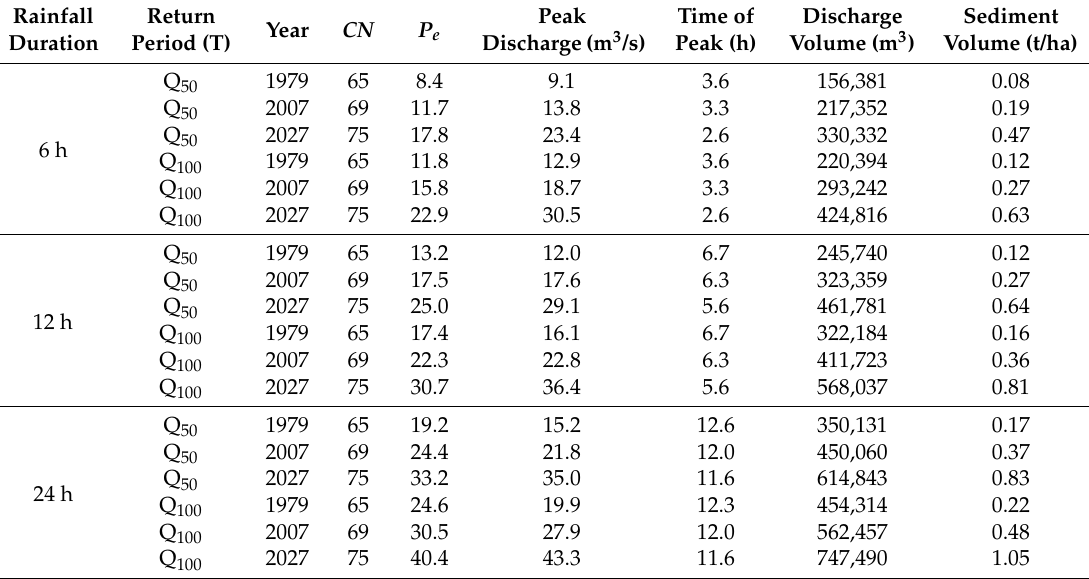
Table 1. Summary of hydrologic and sediment yield modelling